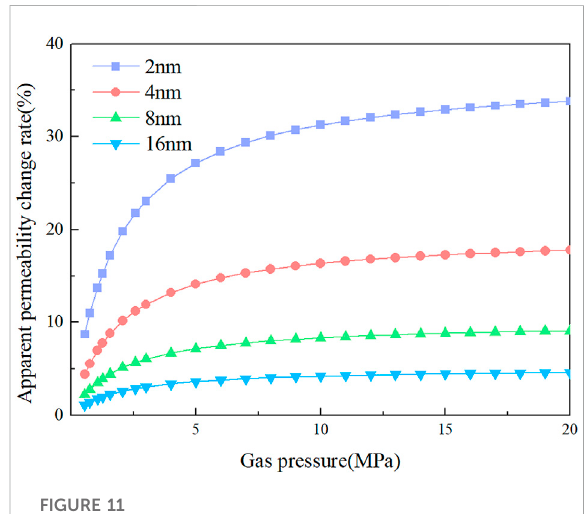
FIGURE 11 Variation in apparent permeability change rate with pressure.